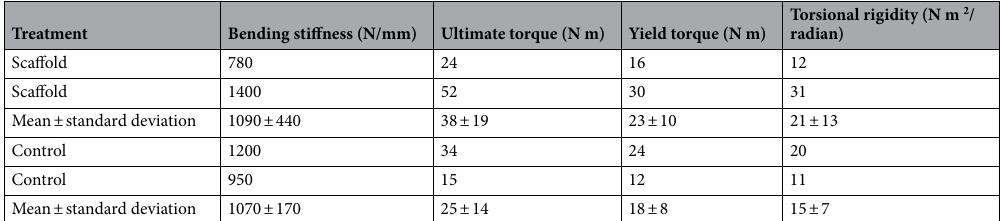
Table 1. Results from four-point bending and torsion tests, showing data from individual specimens and combined treatment means and standard